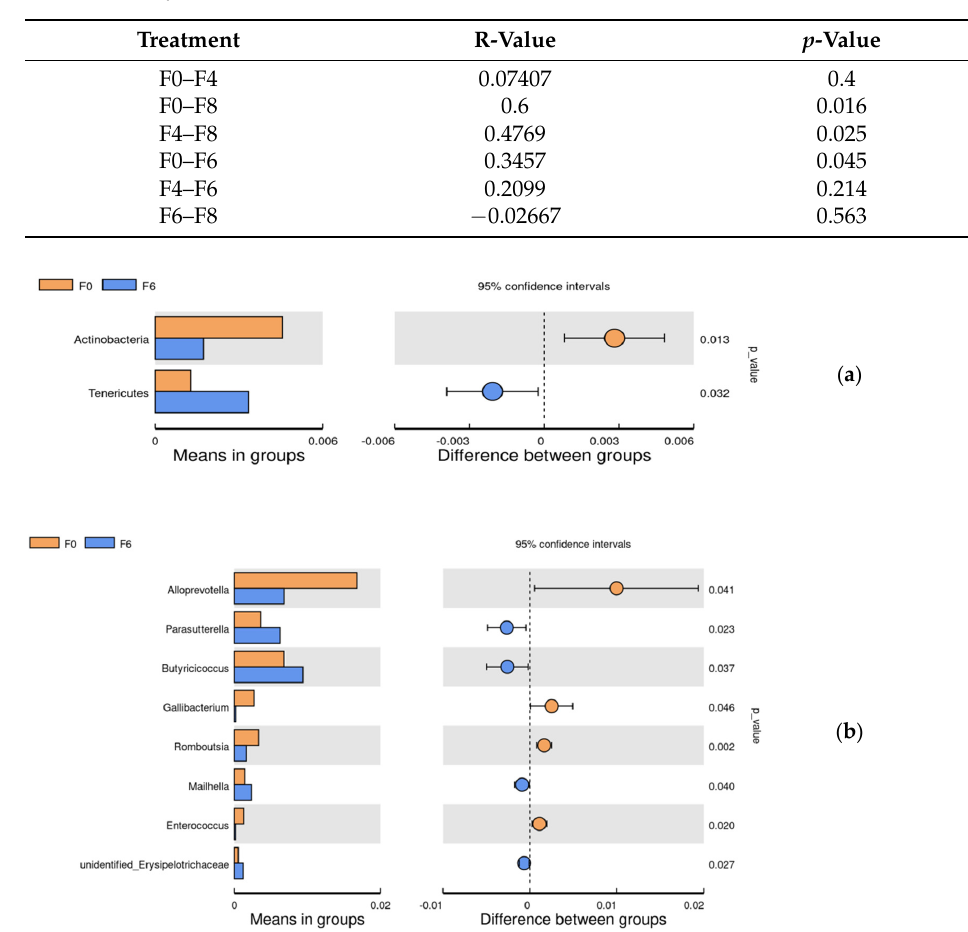
Figure 3. Comparison of the compositions of the cecal microbiota by principal component analysis (PCA). F0, basal diet; F4, 4% fermented mixed feed; F6, 6% fermented mixed feed; F8, 8% fermented mixed feed. Table 6. Comparison of similarities in microbiota composition between the three treatments by ANOSIM analysis.